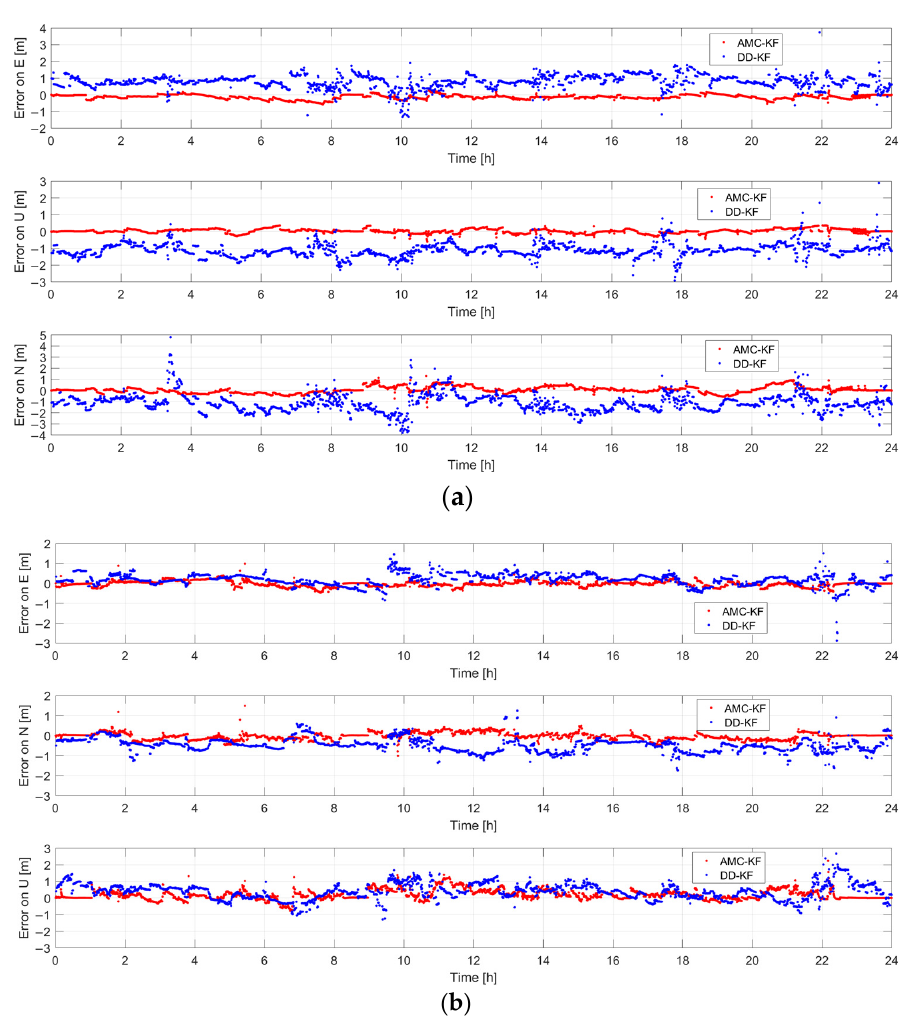
Figure 12. Positioning error on ENU. ( a ) Positioning error of BONE-WBEE; ( b ) positioning error of BONE-GSBN.